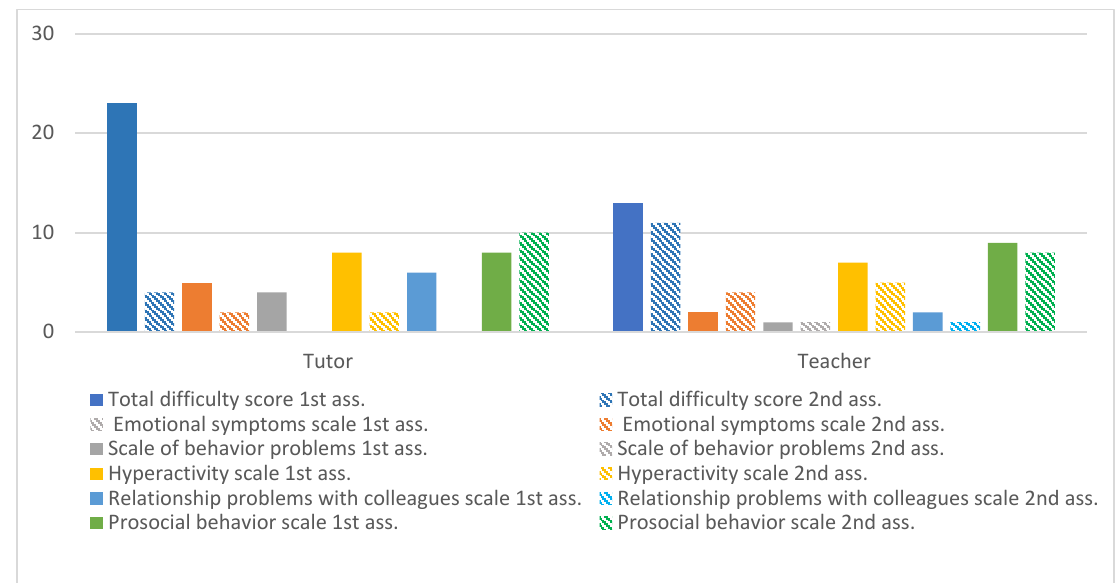
Figure 1. Maria’s global assessment of SDQ .